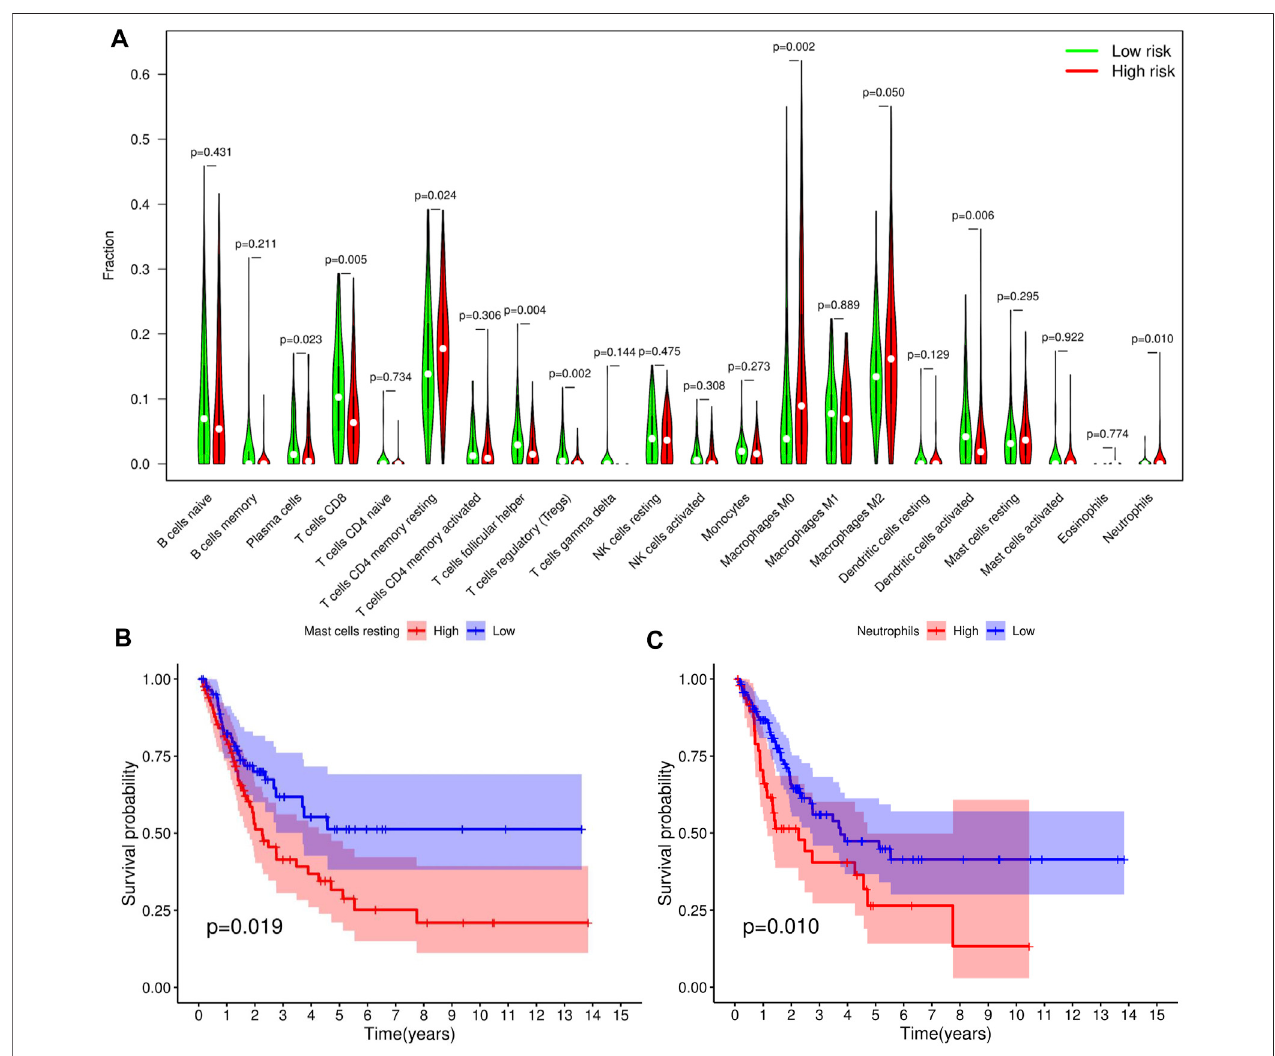
FIGURE 8 | Tumor-in fi ltrating immune cell (TICs) pro fi le of bladder urothelial carcinoma (BLCA). (A) Violin plot showing the difference in the proportion of 22 TIC subtypes in BLCA for the high- and low-risk score (RS) groups. (B,C) Two TICs in fl uencing patients ’ survival outcome.